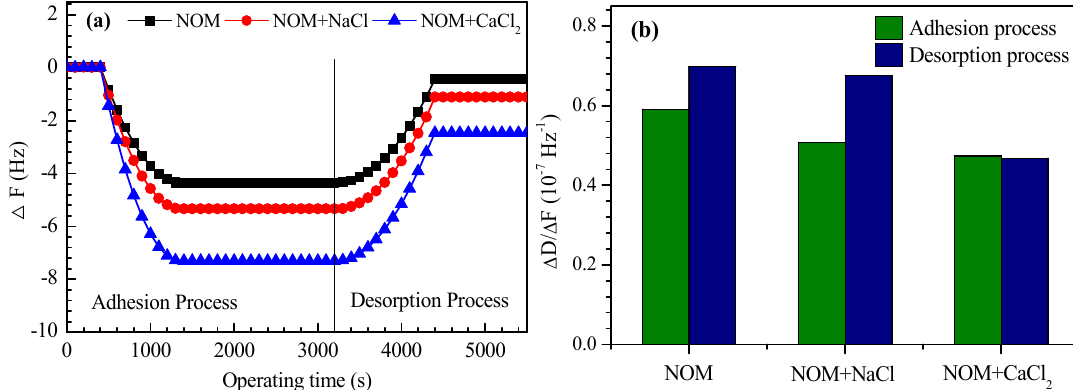
Figure 3. Normalized change in ∆ F ( a ) with time and absolute values of ∆ F / ∆ D ; ( b ) for NOM adhesion on a flat (PES) membrane in the absence or presence of background cations. The dissolved organic carbon (DOC) and pH of the reconstituted NOM were 10 mg / L and 7.0 ± 0.2, respectively. The adhesion test was performed at an ambient temperature of 21 °C, and a flow rate of 0.1 mL min − 1 .